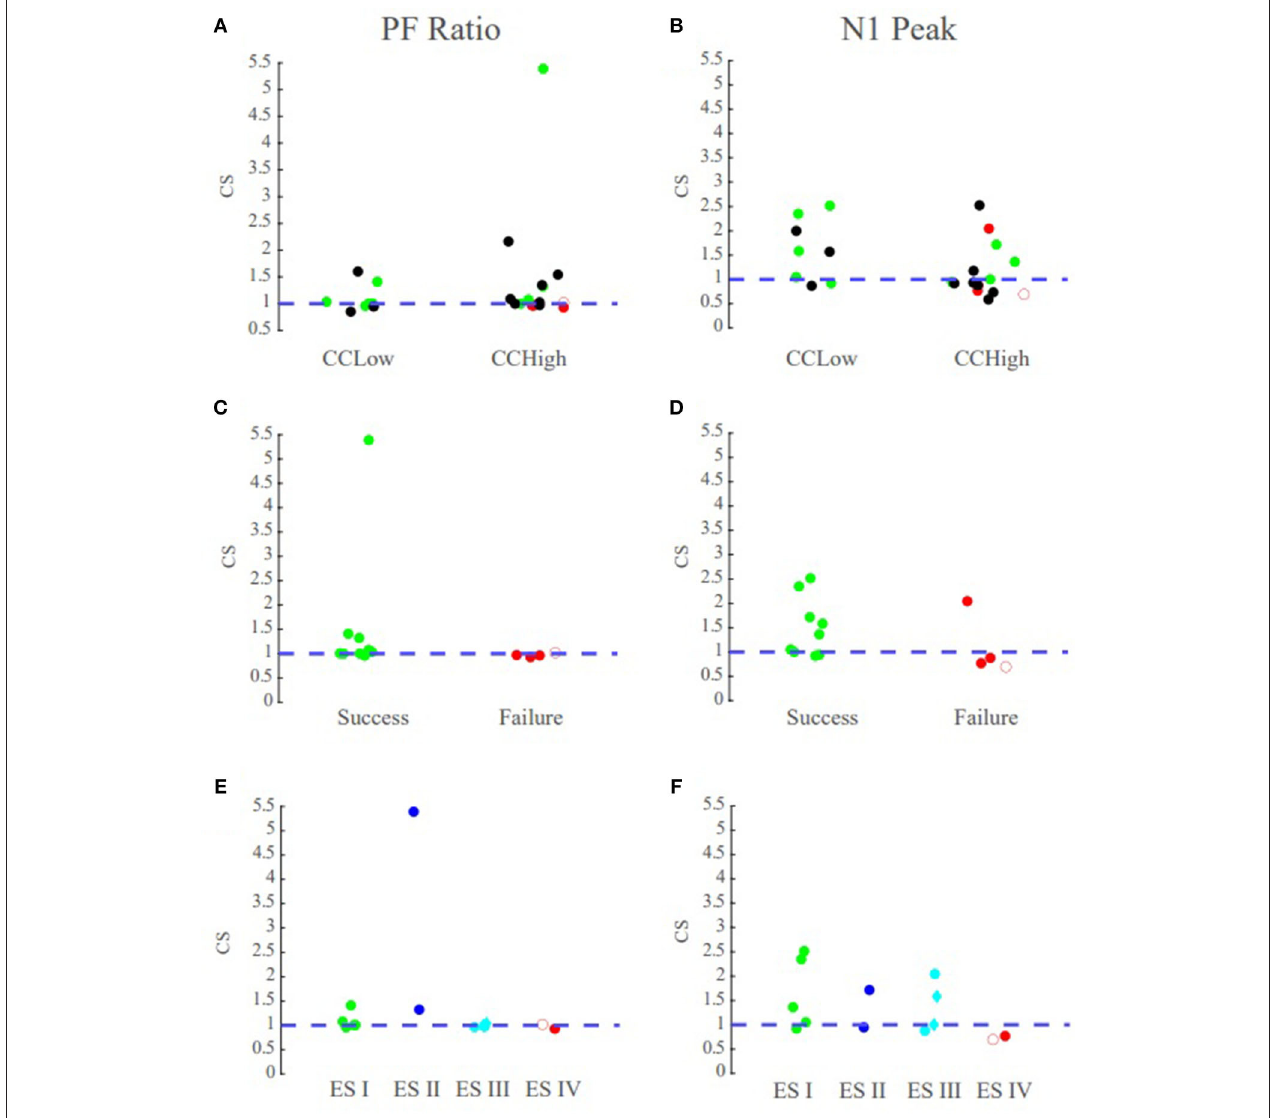
FIGURE 8 | PF ratio confidence statistic reflects surgical outcome. Green circles denote those patients with successful surgical outcomes, red denotes those with failed surgical outcomes, and black denotes datasets that currently have no surgical outcome. The blue dotted line denotes the boundary for the degree of agreement between clinical annotations and the performance metrics. Diamond shape indicates RNS patients and open circle indicates outlier Patient 5. Top row contains the confidence statistic plots for all datasets. Middle row are the confidence statistic plots for surgical patients categorized by surgical success and failures. Bottom row has the confidence statistic plots for surgical patients categorized by Engel Score. (A) The confidence statistic plot for the PF ratio for all datasets. CCLow patients often have CS > 1, and surgical success nearly always have CS values > 1. (B) The confidence statistic plot for N1 peak for all datasets. Less distinction is provided between groups according to the N1 amplitude as compared to system gain. (C,D) Confidence statistic plots for surgical patients categorized by surgical success/failure for (C) PF ratio (D) and N1 peak. (E,F) Confidence statistic plot for surgical patients categorized by Engel score for (E) PF ratio and (F) N1